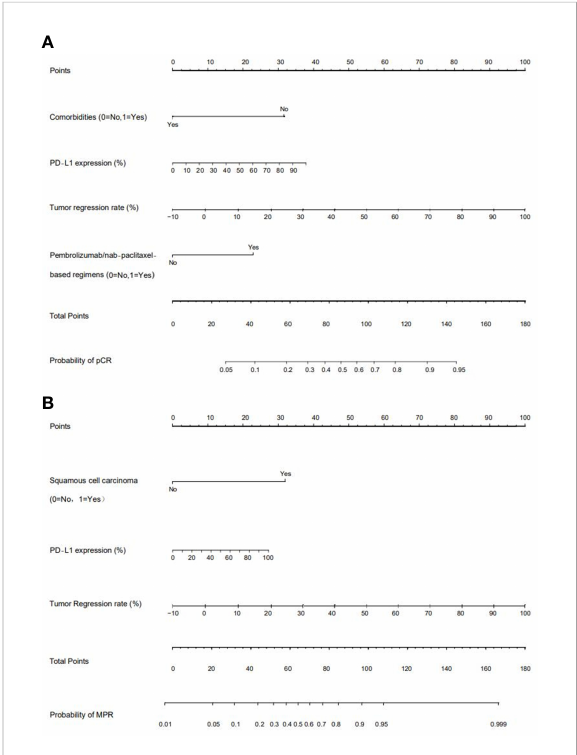
FIGURE 3 Nomograms of predictive models. (A) For pathological complete response (pCR) model; (B) for major pathologic response (MPR) model. PD-L1: programmed death receptor-1